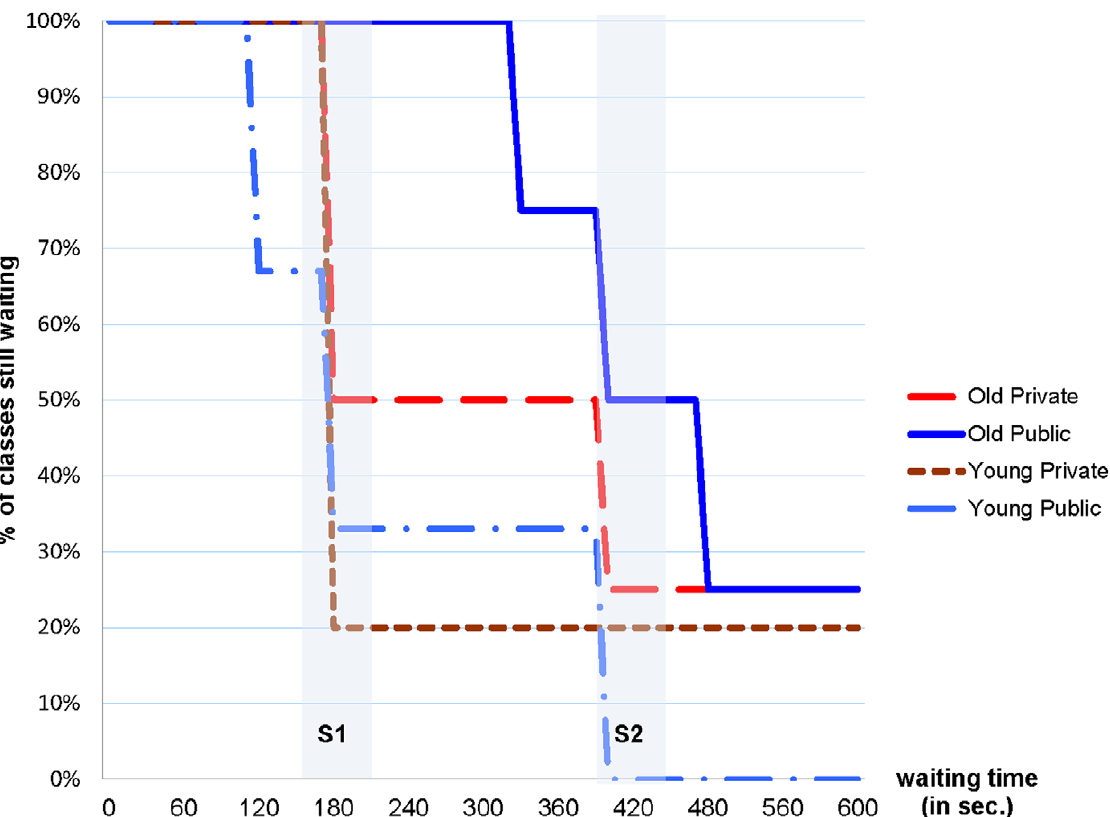
Figure 2. Time path of children’s ability to resist stopping the game. In both conditions, younger children stop sooner. Also, older children in Public resisted longer. All children that stopped the game in the Private Condition avoided doing so publicly.